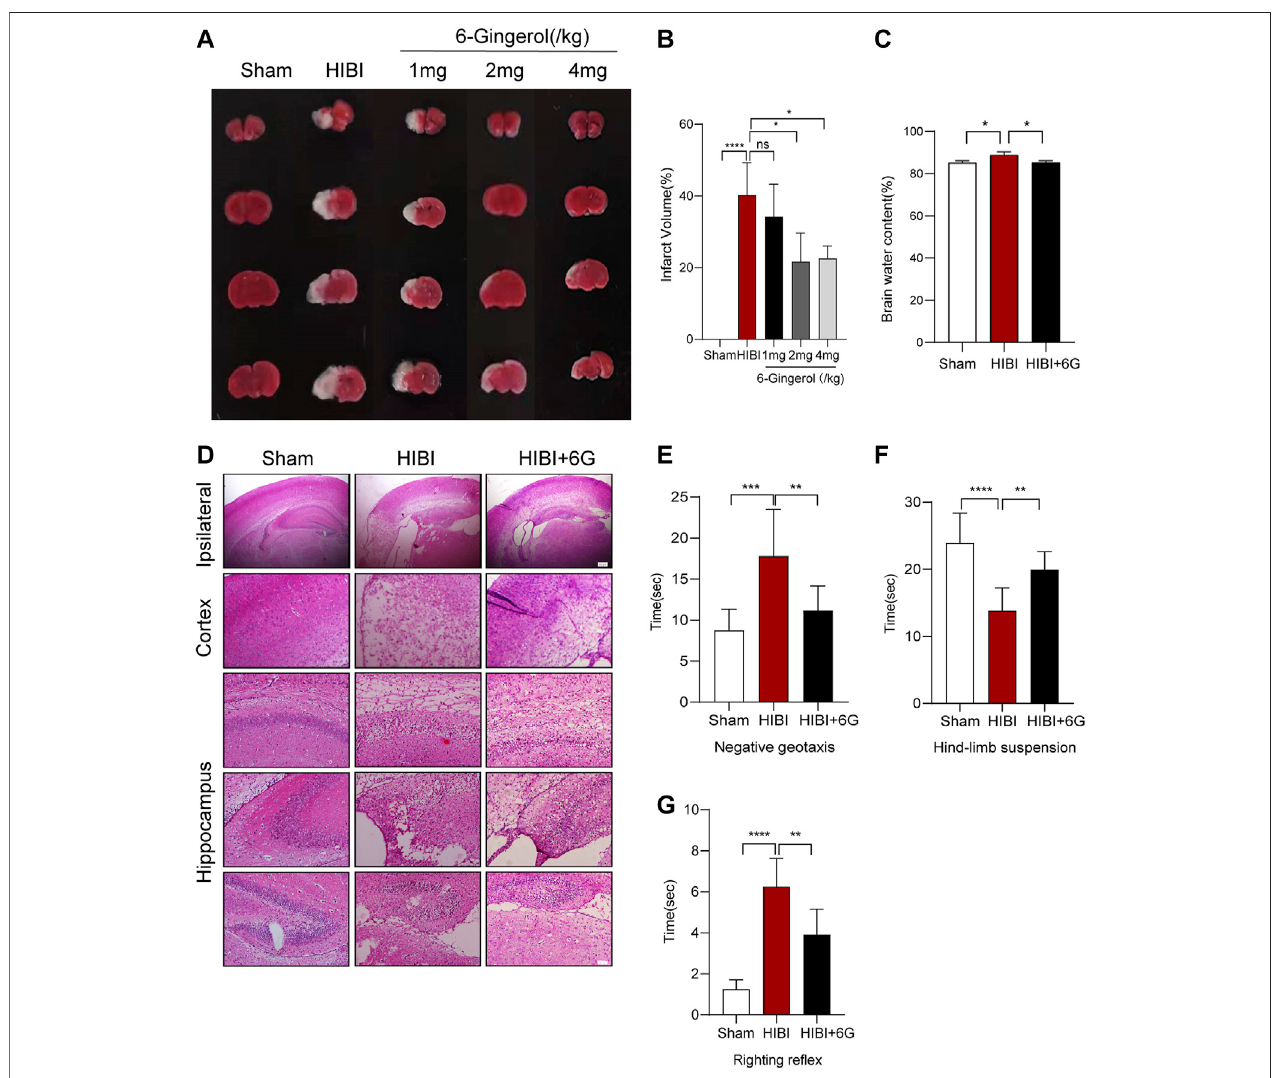
FIGURE 1 | Effect of 6-Gingerol on brain infarct area and neurological re fl exes. (A) Triphenyl tetrazolium chloride (TTC) staining of the Sham, HIBI and HIBI+6G groupwithdifferent6-Gingeroldosesfortreatment. (B) CalculationofbraininfarctareashownbyTTCstainingfrom Figure1A . (C) Calculationofbrainwatercontent. (D) Representative pictures of hematoxylin and eosin (HE) staining. n (cid:1) 3-4 per group in A-D. lpsilateral, scale bar (cid:1) 200 μ m. Cortex and hippocampus, scale bar (cid:1) 50 μ m. (E – G) Performance of negative geotaxis, hind-limb suspension and righting re fl ex. n (cid:1) 8 per group. Data represent the mean ± SEM. * p < 0.05, ** p < 0.01, *** p < 0.001, **** p <